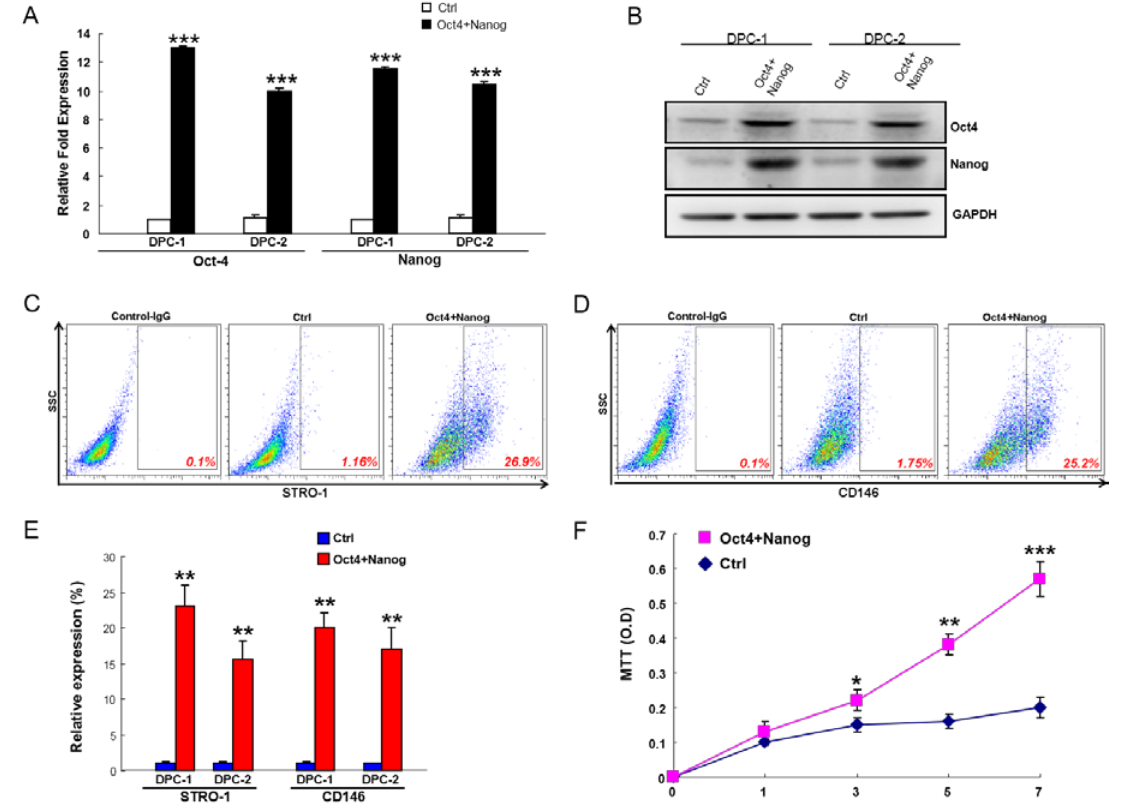
Figure 4. Overexpression of Oct4/Nanog in DPCs enhances STRO-1 expression and proliferation rate. Expression of Oct4 / Nanog transcript ( A ) or protein ( B ) in DPCs infected with either Oct4 / Nanog -overexpressing or control GFP lentiviruse were examined by real-time RT-PCR analysis ( A ) and western blot ( B ); The amount of GAPDH protein was referred to as the loading control; ( C ) STRO-1 and ( D ) CD146 expression in Oct4 / Nanog -overexpressing or control-GFP DPCs was analyzed by flow cytometry; ( E ) STRO-1 and CD146 expression of Oct4 / Nanog co-overexpressing DPCs were calculated and presented in the chart; ( F ) The proliferation rate of control-GFP and Oct4 / Nanog overexpressing DPCs was analyzed by MTT assay. Data shown here are the mean ± SD of three independent experiments. ( * p < 0.05; ** p < 0.01; *** p <